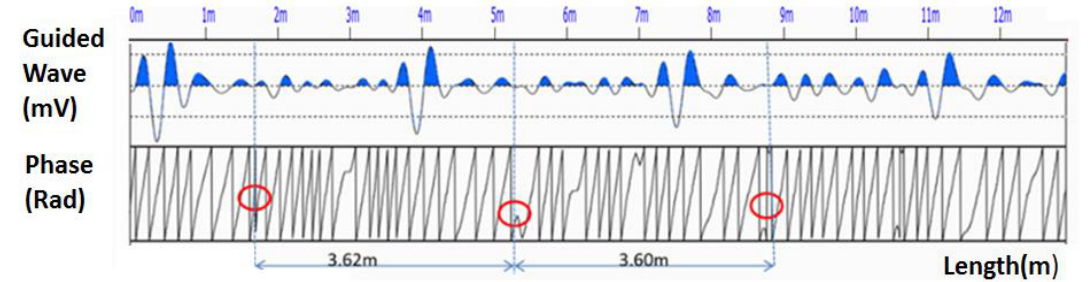
Figure 13. The length extraction process of rock bolt No. 203.